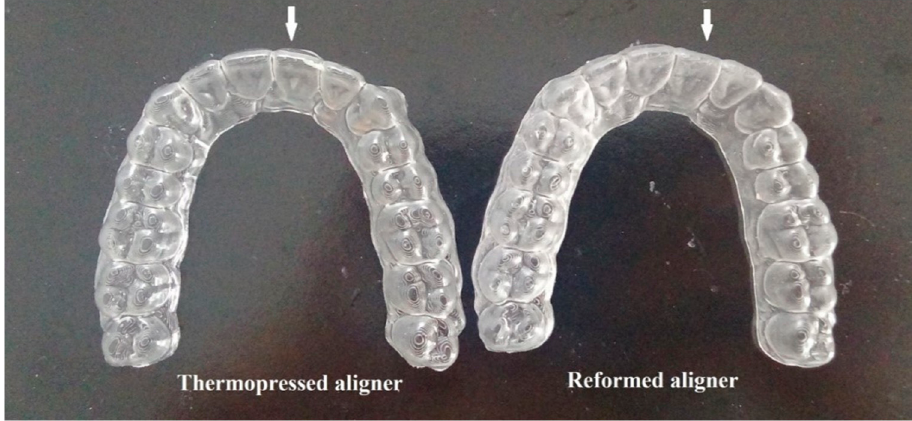
Figure 3. Thermopressed aligner on model 2 and reformed aligner on model 1.